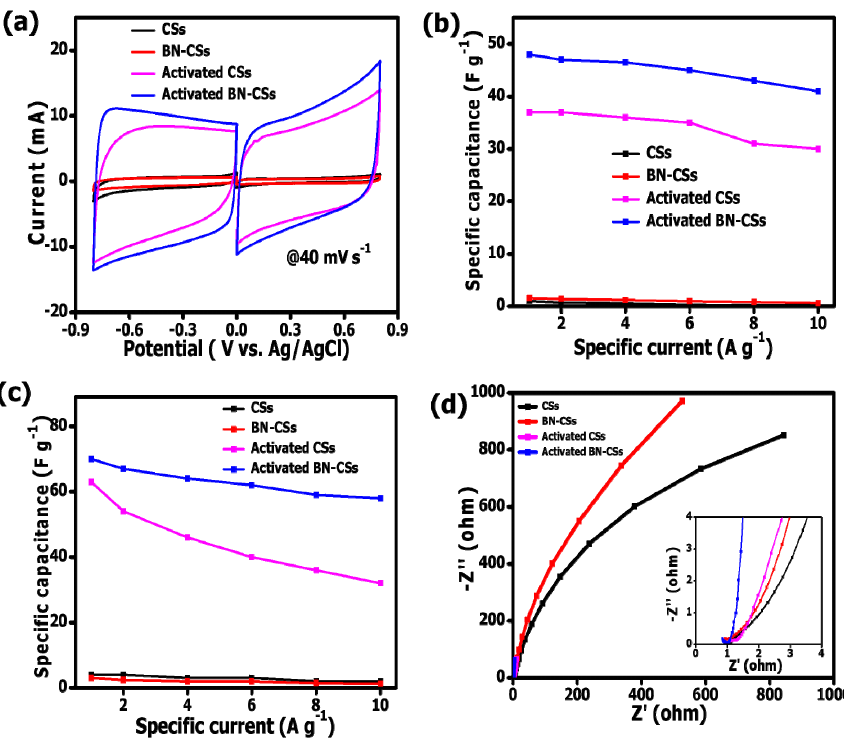
Figure 5. Pristine and activated CSs and BN-CSs: ( a ) CV curves at a scan rate of 40 mV s − 1 , and ( b , c ) specific capacitance calculated versus specific current for both positive and negative potential windows and ( d ) Nyquist plots in 3 M KNO 3 electrolyte.